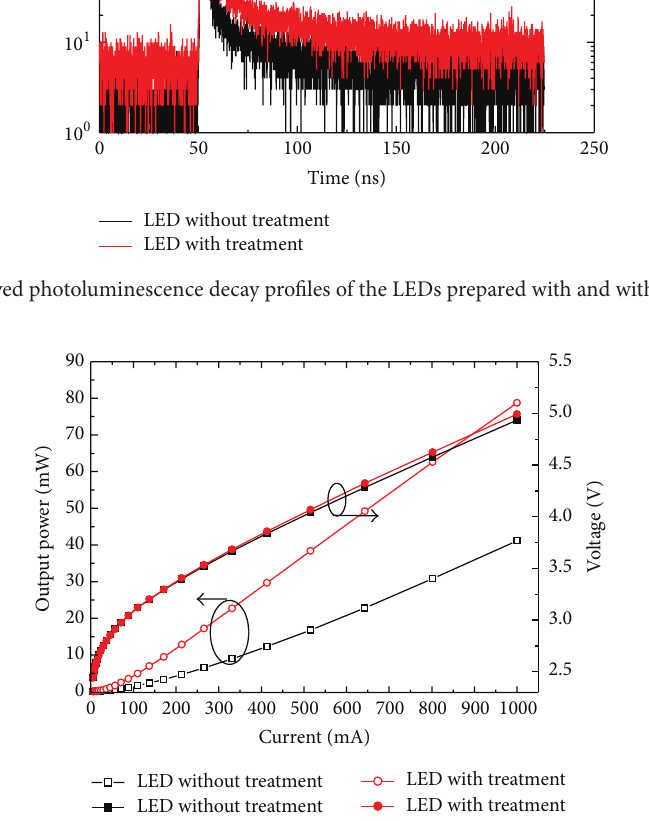
Figure 7: Plots of light output power and forward voltage with respect to injection current for the LEDs prepared with and without TMIn